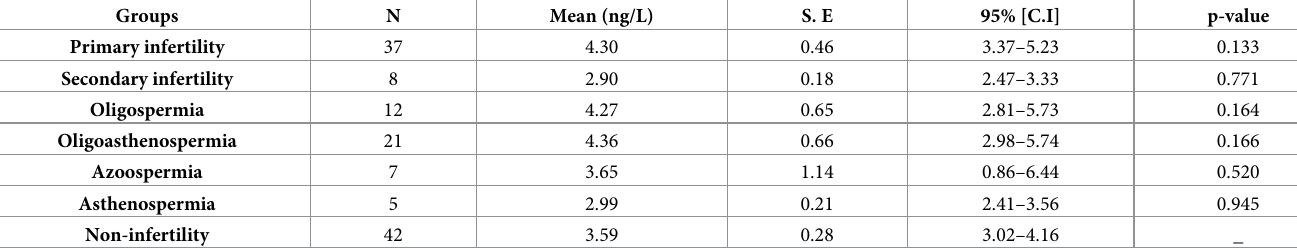
Table 5. Status of IL-6 in different types of male infertility.